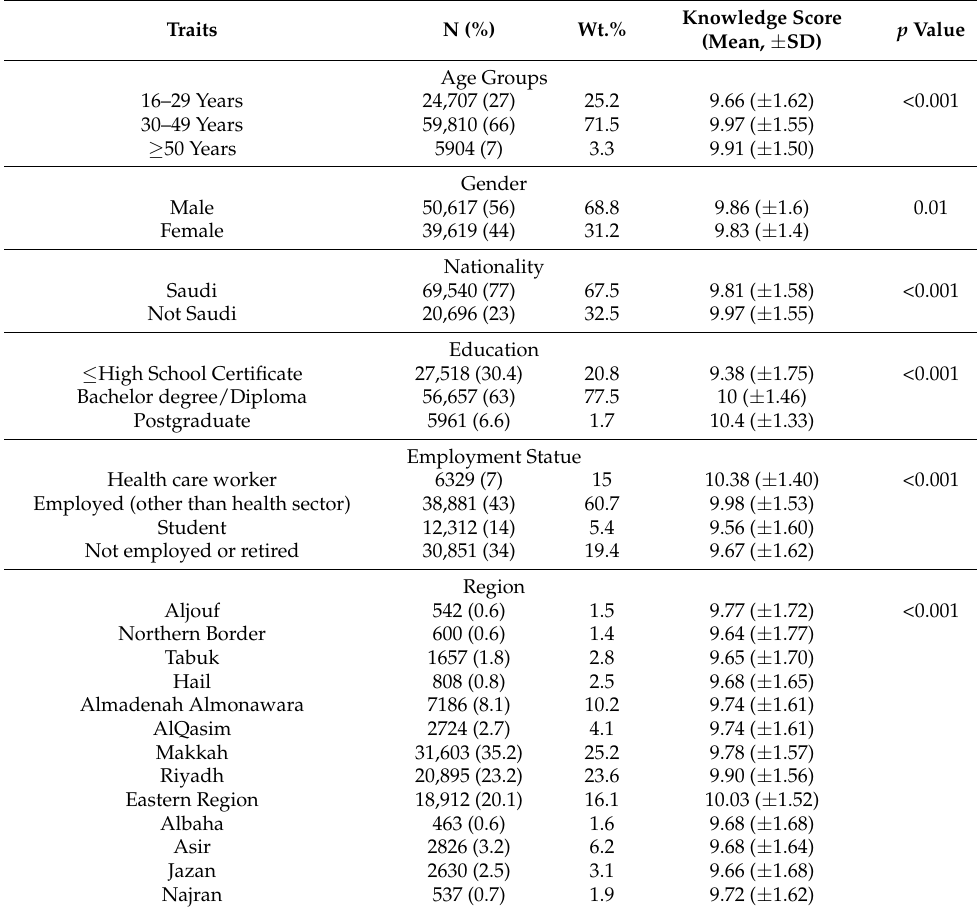
Table 1. Demographic characteristics of